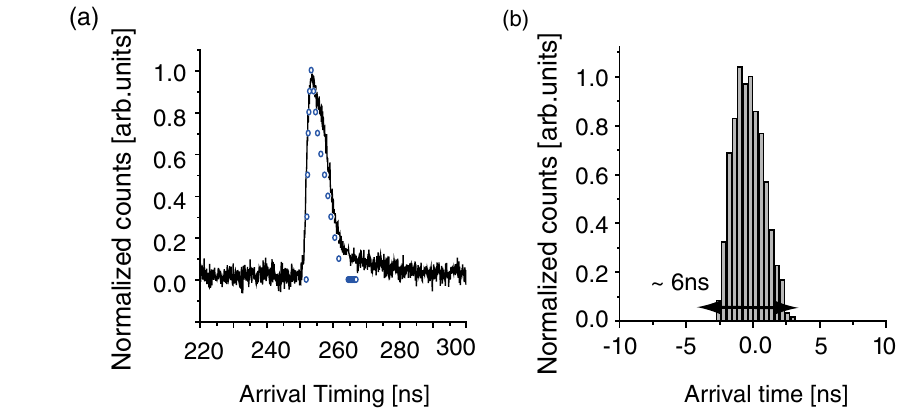
FIG. 7. (Color) (a) Normalized transmitted TOF signal measurement (black line) and the PARMILA simulation which includes the response time of the TOF spectrometer (open circles) at plane ‘‘g’’. (b) Simulated normalized transmitted TOF result which does not include the response time of the TOF